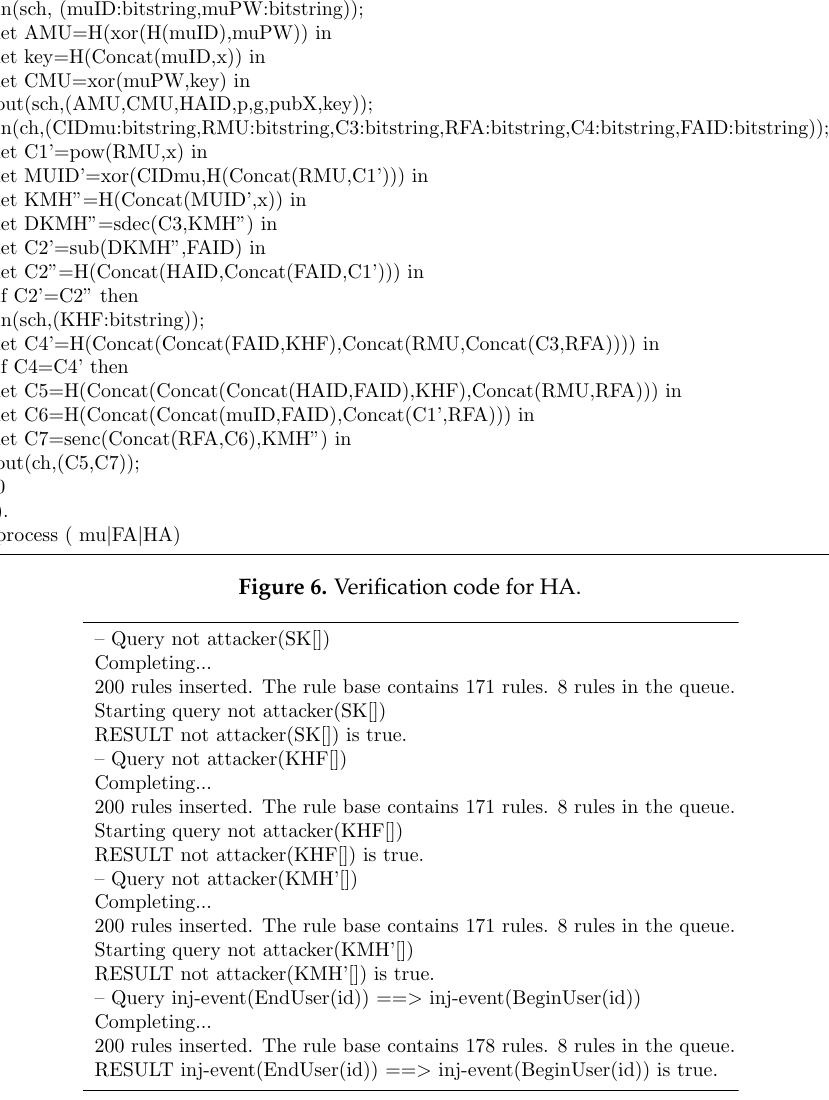
Figure 7. Verification